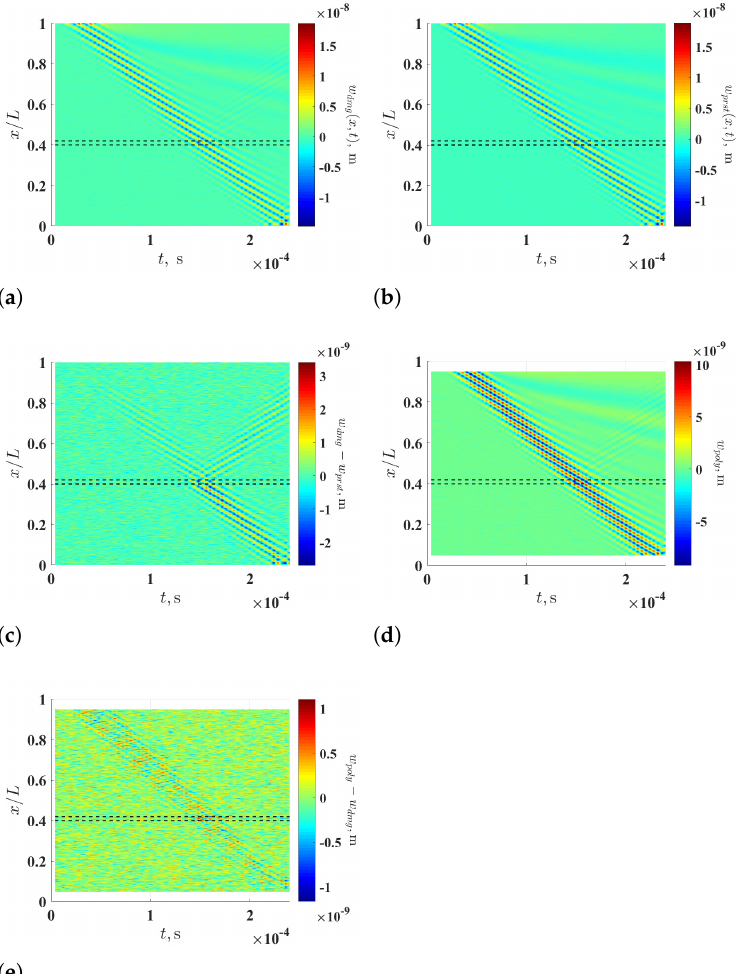
Figure 2. Noise-contaminated waveforms of the propagating flexural waves of the ( a ) damaged and ( b ) pristine beams from the finite element models, ( c ) the difference between the waveforms in ( a , b ), ( d ) waveforms of the propagating flexural wave of the pseudo-pristine beam and ( e ) the difference between the waveforms in ( a , d ). The locality and extent of the damage are indicated by two dashed